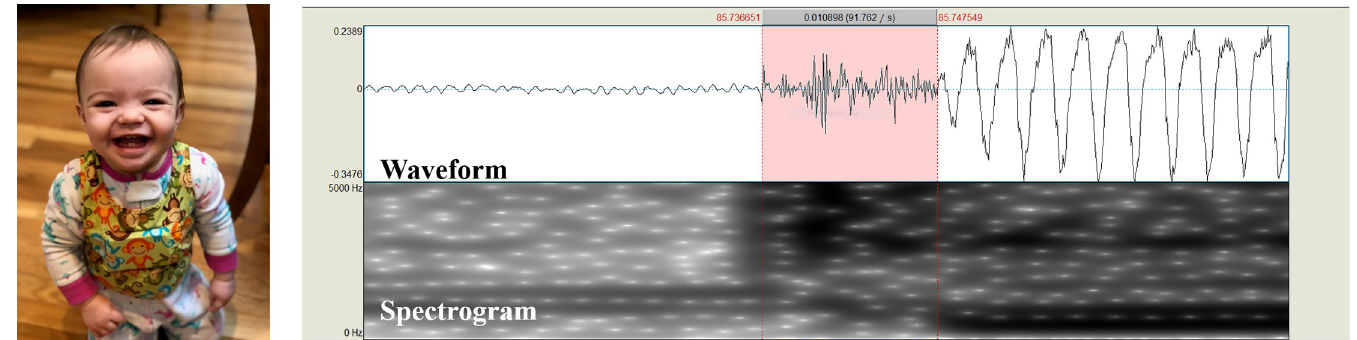
Fig 2. LENA vest (left) and Voice onset time example (Right). Left: An infant wearing the LENAvest during recording (The parent of the infant pictured in this manuscript has given written informed consent (as outlined in PLOS consent form) to publish these case details). Right: Praat window with waveform and spectrogram from a stop consonant-vowel production. Voice onset time is measured from the burst to the start of the subsequent vowel, indicated by the highlighted portion.